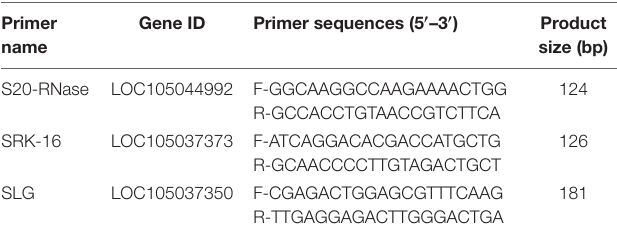
TABLE 2 | Primer sequences and amplicon length used for RT-qPCR analysis.